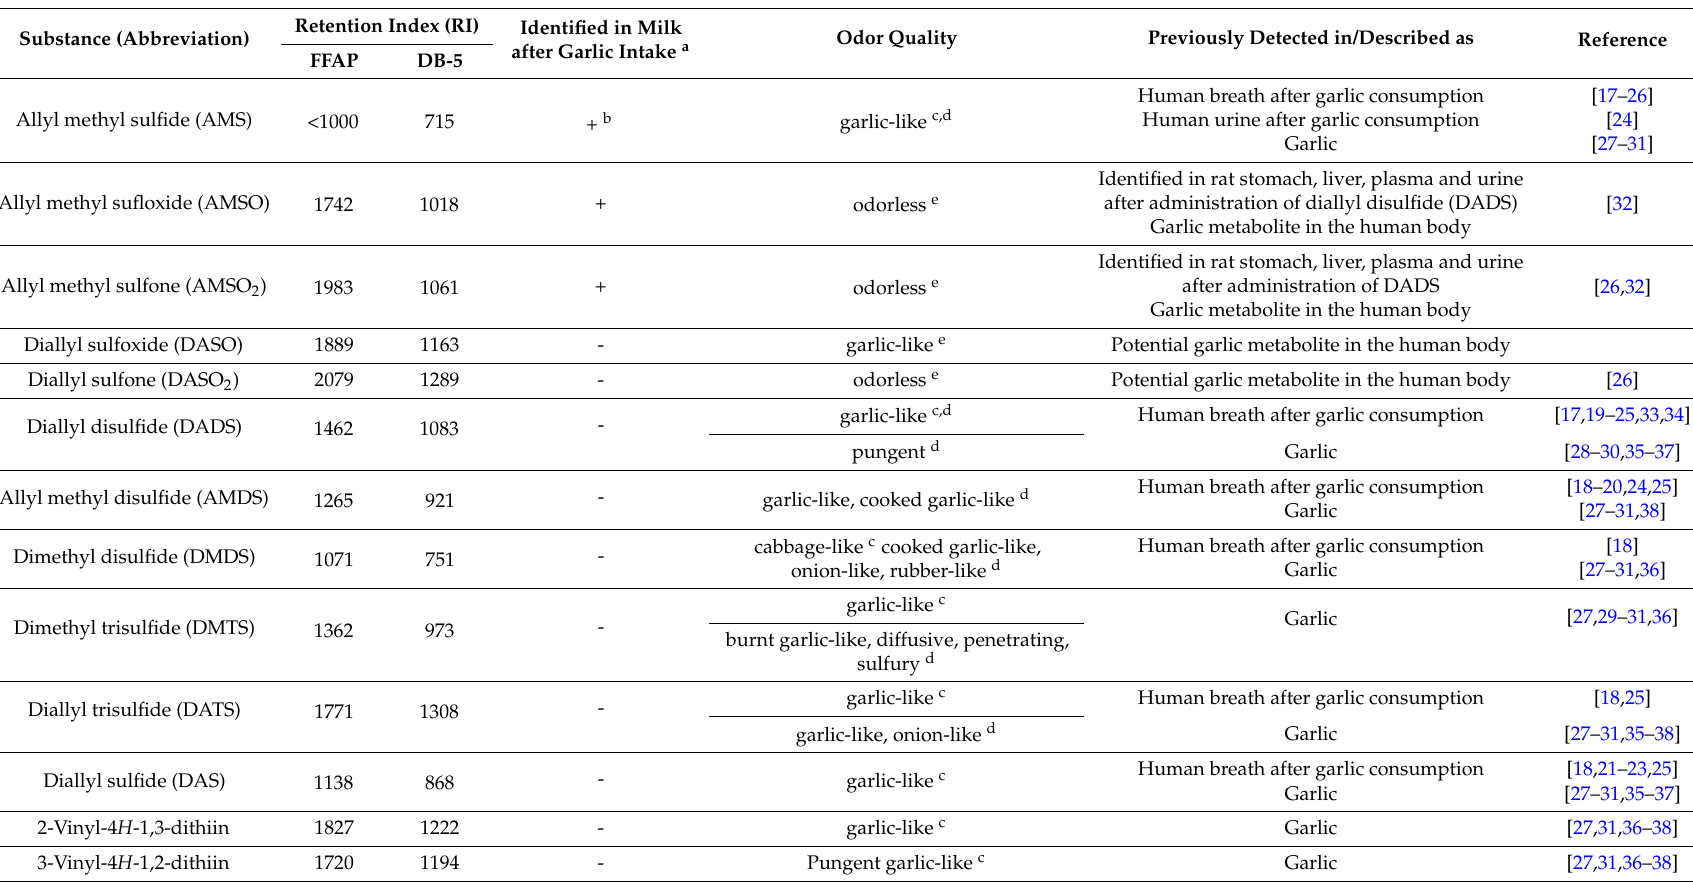
Table 1. Retention indices on DB-FFAP and DB-5 chromatographic capillaries and odor qualities of all substances investigated in this study. Literature reports on